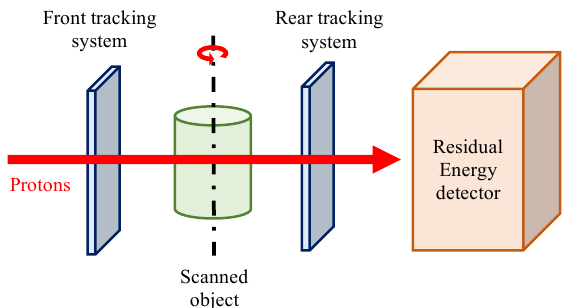
Fig. 1. Schematic structure of a pCT